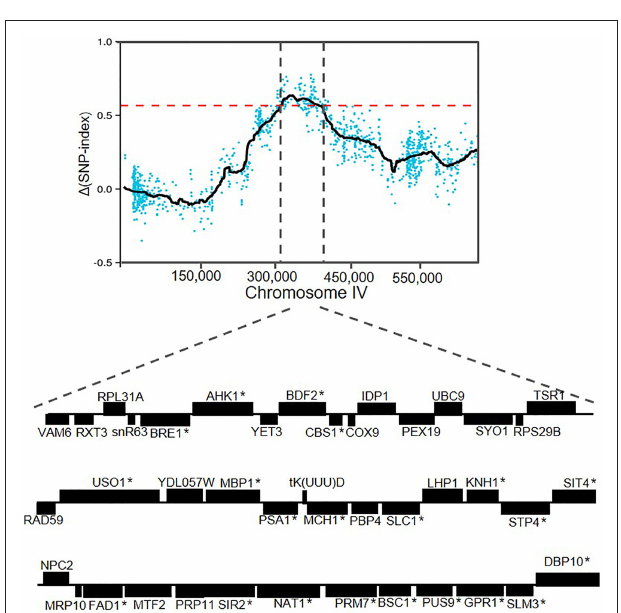
FIGURE 6 | Overview of genes in the QTL on chromosome IV. The region between 319,200 and 397,400 bp, containing 42 genes. The genes containing at least one non-synonymous mutation within the open reading frame were indicated with an